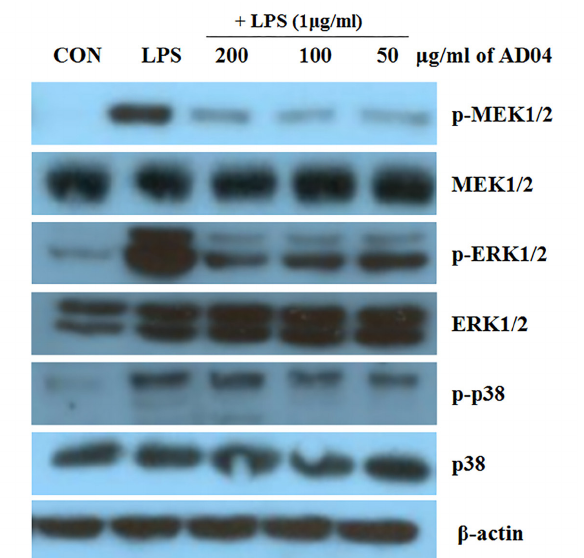
Fig. 5: Effects of BuOH fraction (AD04) on the activation of the LPS-in- duced MAPK signaling pathway. Immunoblotting was performed using the lysate from RAW264.7 cells treated with or without LPS in the presence of AD04. Blots were incubated with antibody anti-phospho-MEK1/2 (p-MEK1/2), anti-MEK1/2, anti-phospho- ERK1/2 (p-ERK1/2), anti-ERK1/2, anti-phospho-p38 (p-p38), and p38. β-actin was used as a loading